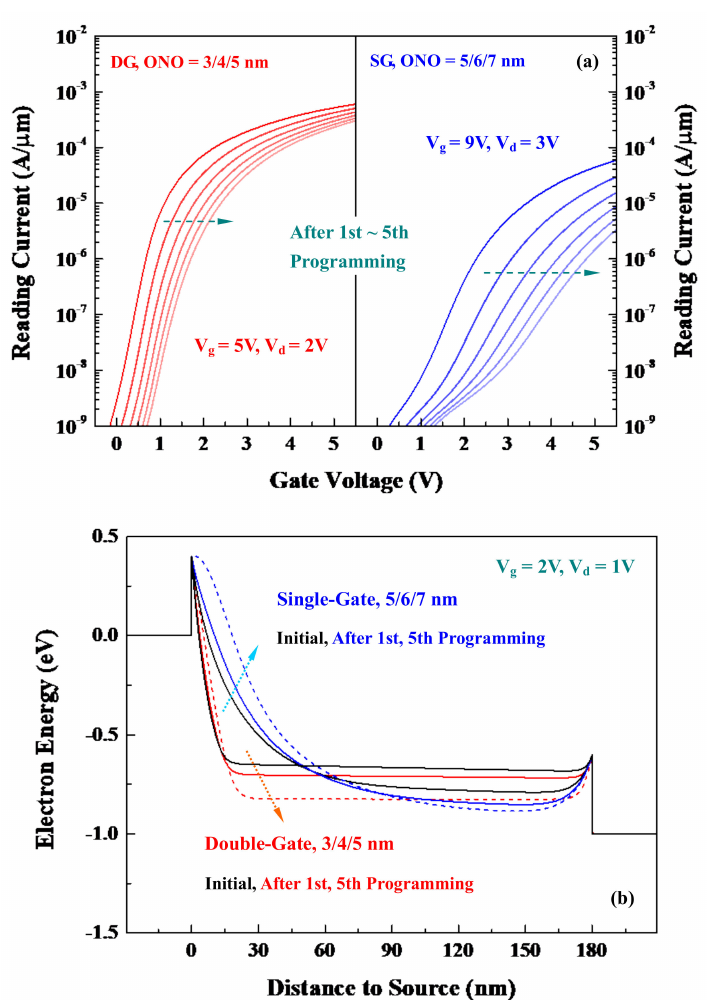
Figure 13. ( a ) Reading currents of two types of Schottky barrier charge-trapping cells after each programming interval (V read = 1 V); ( b ) associated conduction band diagrams of Schottky barrier cells along the channel surface at reading bias